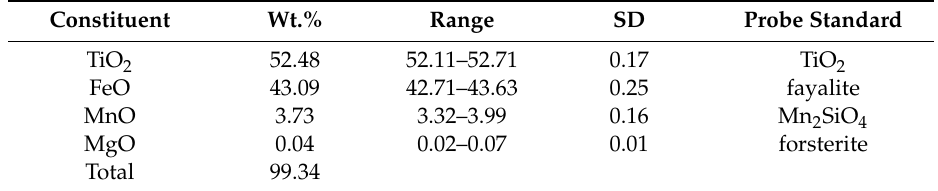
Table 3. Chemical analysis of wangdaodeite and ilmenite from Ries xenolith ZLN114c. The two minerals are not distinguishable by composition. The values are based on the average of the 12 point analyses.